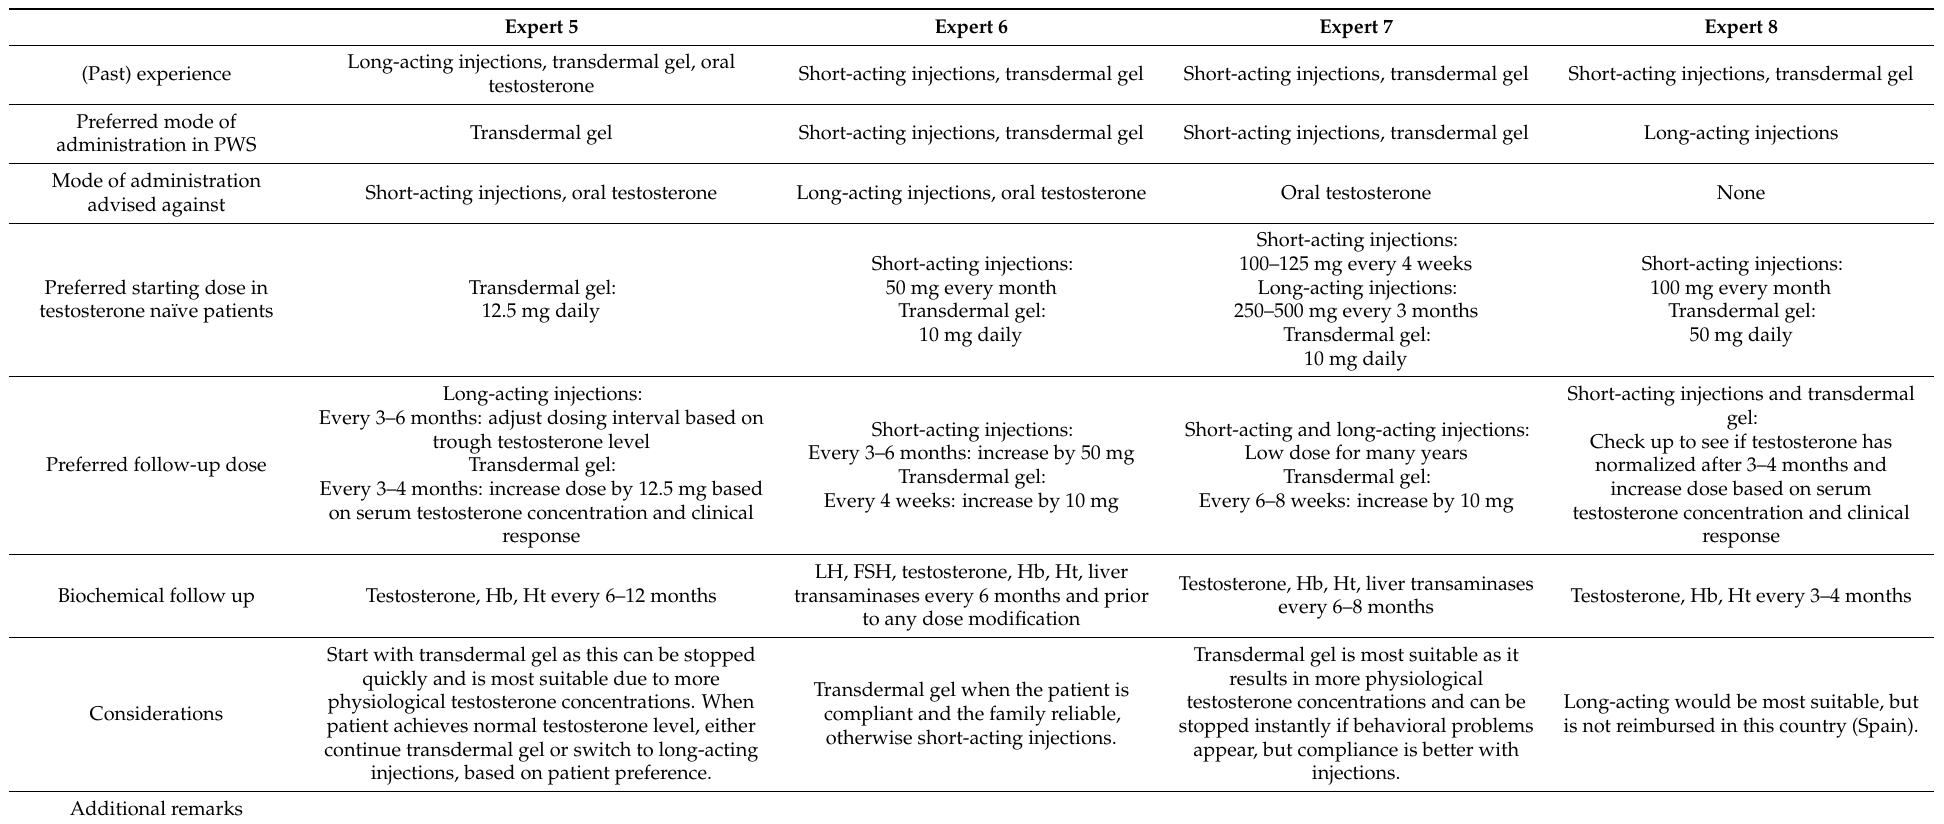
Table 8. Expert panel discussion (Part